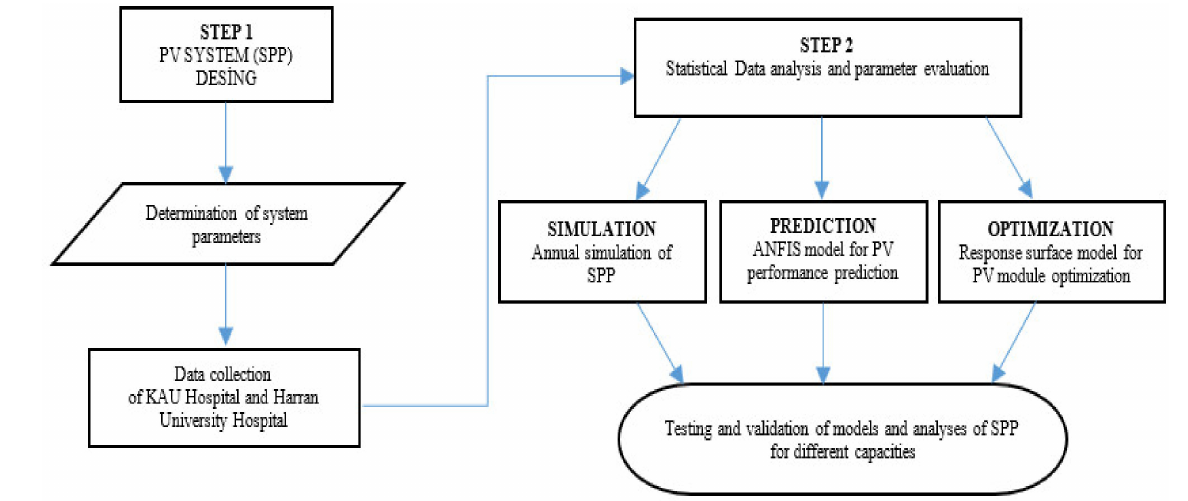
Figure 1. The solar PV panel system flow chart.